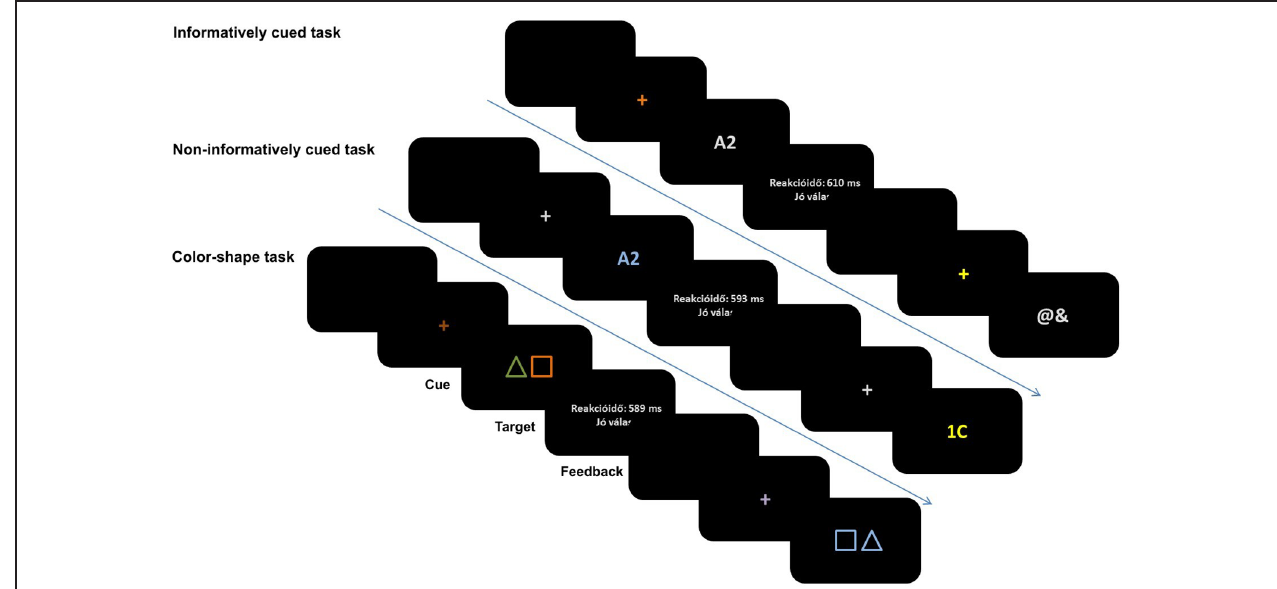
FIGURE 1 | Illustration of the sequence of stimuli in the three types of task-switching paradigms.